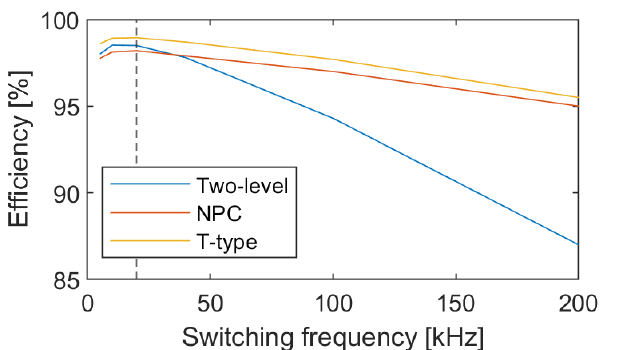
Figure 19. Simulated efficiency of AFE topologies for various switching